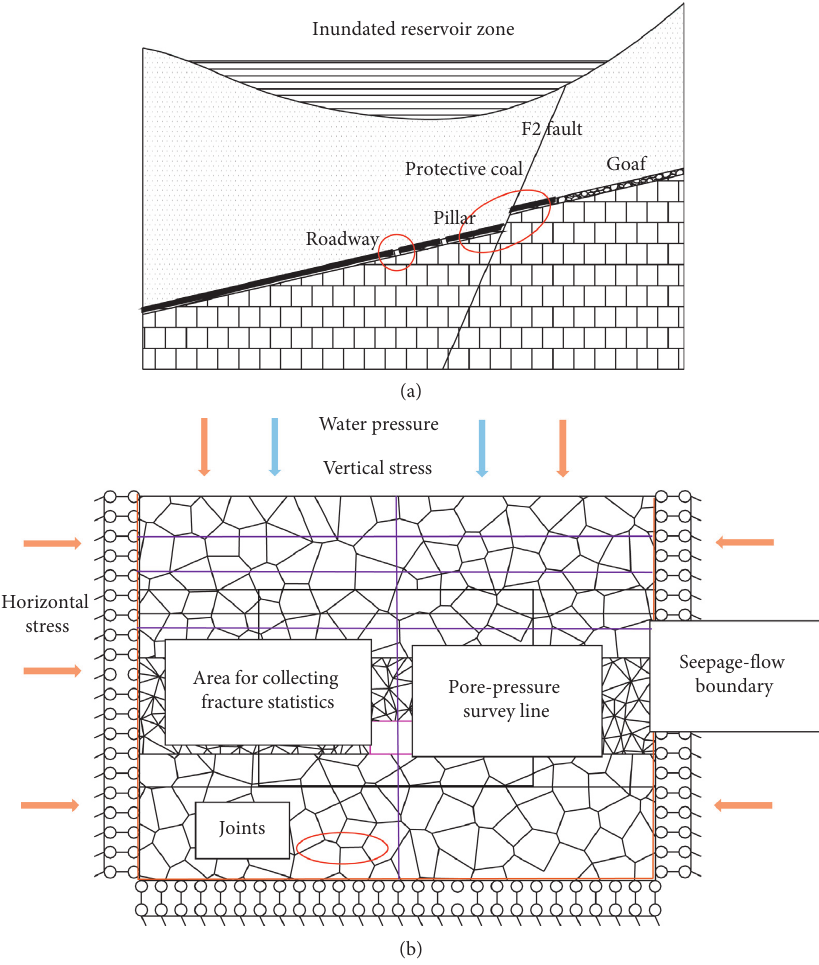
Figure 9: Hydrogeological and numerical calculation models. (a) Schematic of hydrogeological structure. (b) Numerical calculation model.